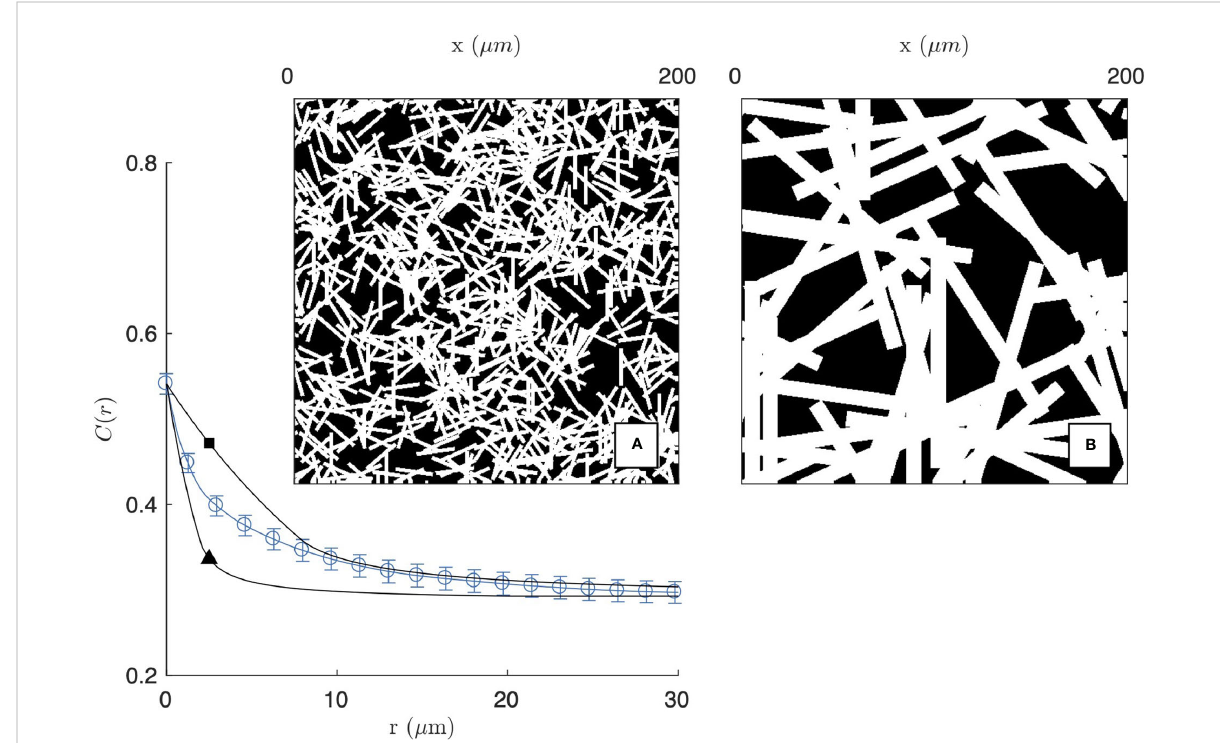
FIGURE 3 Homogeneous fi bre model, obtained as a Boolean model of randomly oriented rectangles. The two realisations are obtained with length and diameter L F = 20 µm, D F = 1 µm ( A and ▲ ) and L F = 100 µm, D F = 10 µm ( B and □ ), and the calculated covariances are compared with that of the 2 mg/mL gel imaged by CFM (same as Figure